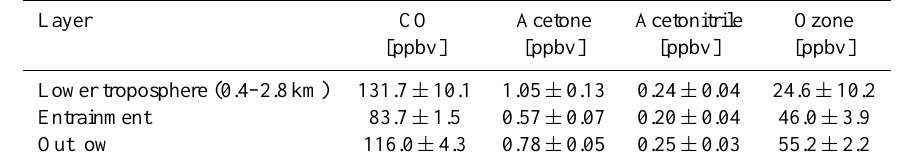
Table 4. Average mixing ratios and associated standard deviation of different trace gases in the considered layers.